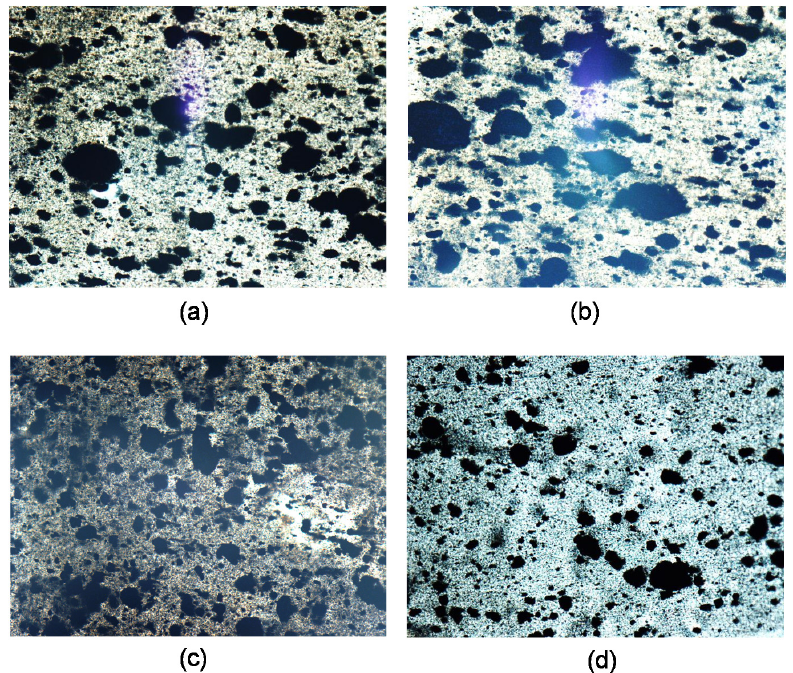
Figure 1. Optical micrographs for nanocomposites for isotactic polypropylenes/multi ‐ wall carbon nanotubes (iPP/MNT) (10 wt %) fabricated by melt extrusion with and without ultrasound ‐ assist fabrication for iPP MFI = 2.5 . ( a ) W ‐ U; ( b ) F ‐ U; ( c ) PT; ( d ) V ‐ U. Table 2. Agglomerate size ( μ m) for iPP/MNT nanocomposites fabricated by different methods.